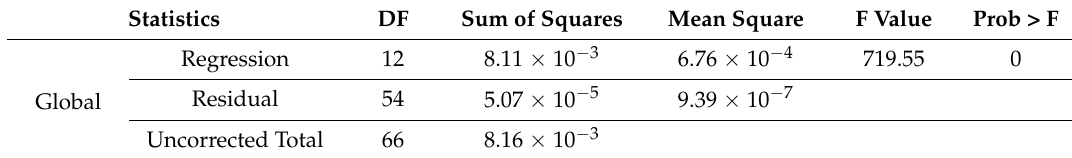
Table 6. Results for variance analysis through Gaussian model fitting. DF Sum of Squares